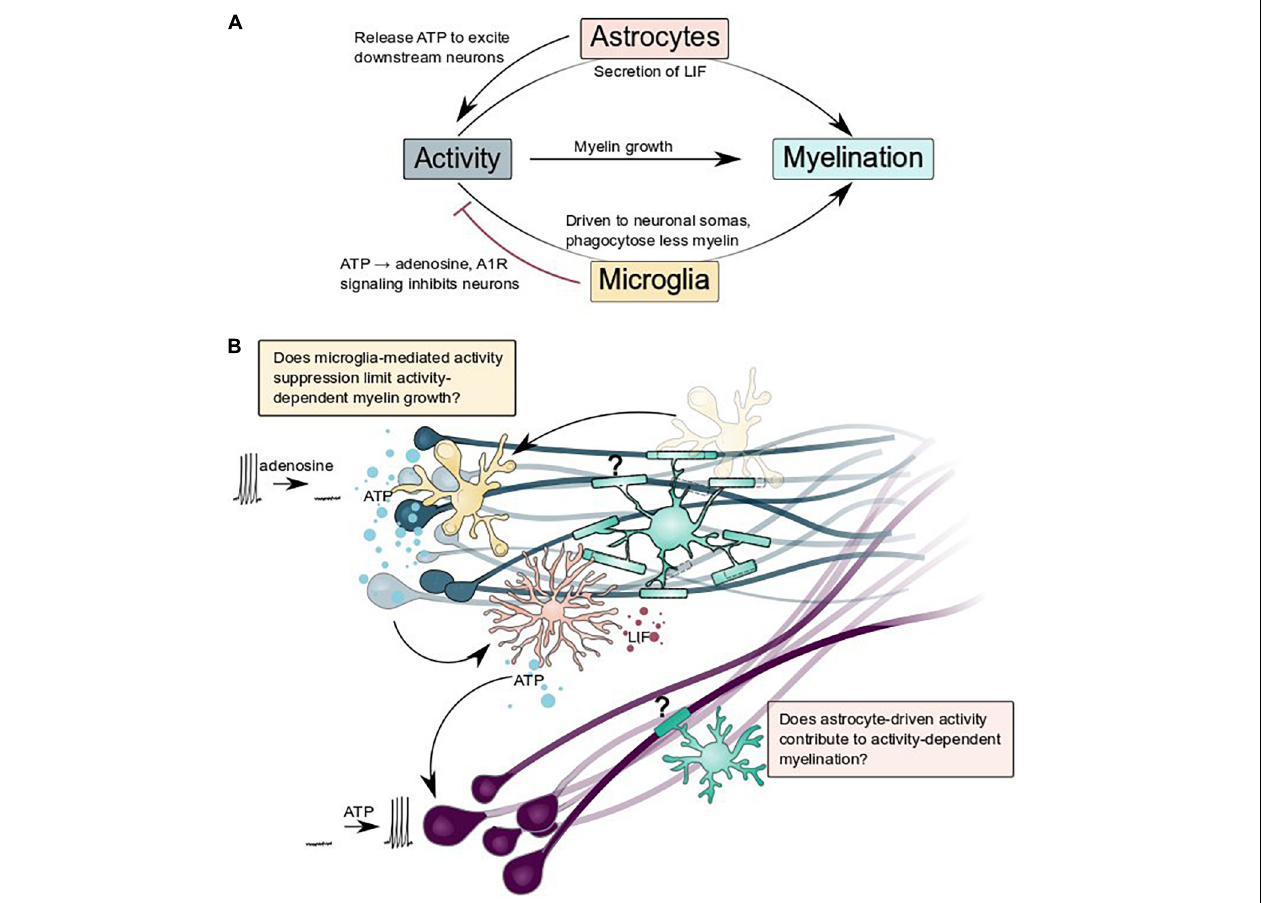
FIGURE 4 | Astrocytes and microglia regulate and are regulated by neuronal activity: what are the consequences for activity-dependent myelination? (A) Summary schematic of interactions between astrocytes, microglia, neurons, and myelination described by Ishibashi et al. (2006), Badimon et al. (2020), Ma et al. (2016), and Hughes and Appel (2020). (B) Does glial regulation of neuronal activity change activity-dependent myelination? Does microglial suppression of activity (blue neurons) and astrocytic release of ATP to excite nearby neurons (purple) contribute to activity-dependent myelination?